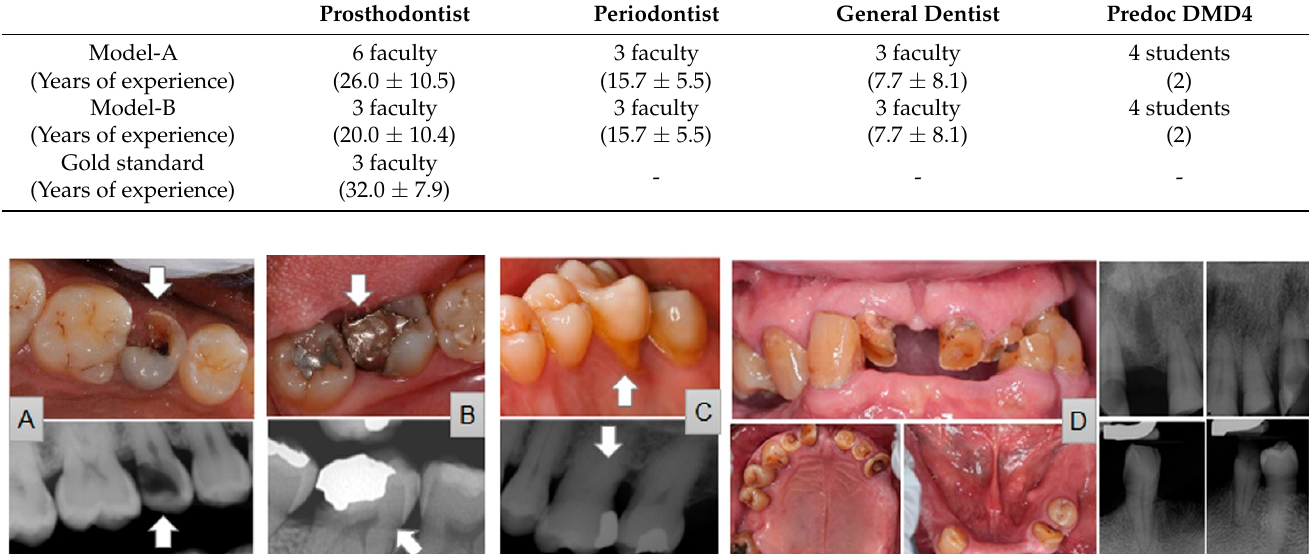
Table 2. Distribution of participants for ranking of tooth prognosis (mean ± SD).